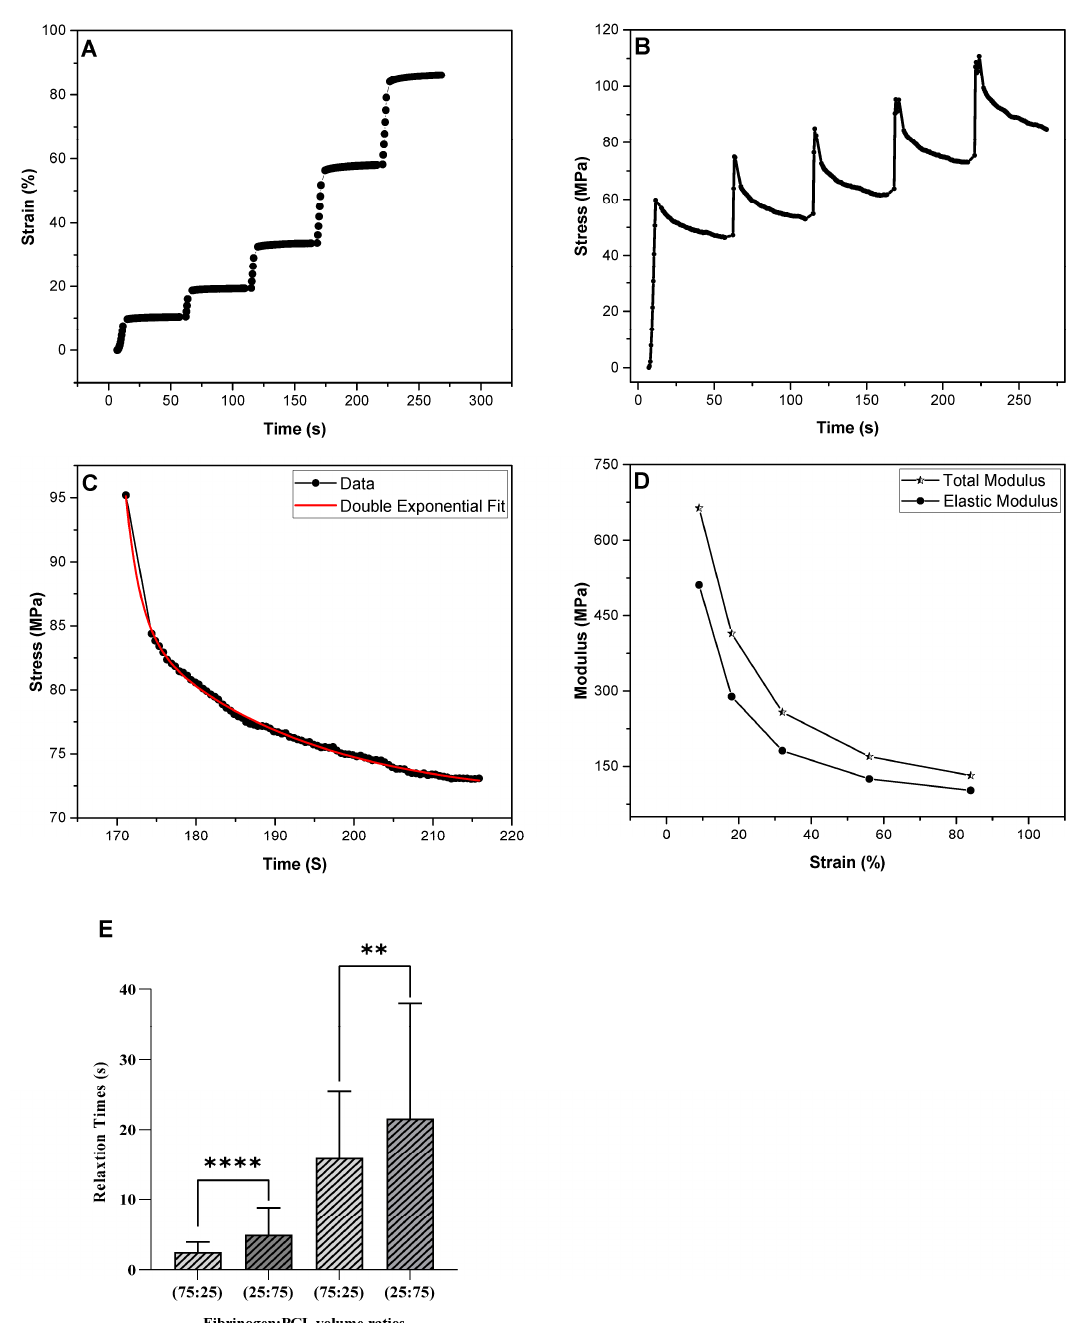
Figure 4. Incremental stress–strain curves. ( A ) Strain versus time curve for electrospun 75:25 fibrinogen:PCL fiber. The fiber was pulled to a small strain (~10%) and held constant for approximately 30–40 s; this process was repeated with a slightly larger strain at each time. ( B ) Stress versus time curve. At constant strain, the stress relaxes and decays exponentially with time. ( C ) Representative stress relaxation curves. A double exponential curve is fitted to the relaxation curve (R 2 = 0.99) to determine the relaxation times. The fast and slow relaxation times for this curve were 1.8 s and 21 s. ( D ) Moduli versus strain curve. The total modulus, Y tot , (stars) and relaxed, elastic modulus, Y 0 , (dots) decrease as the strain increases. ( E ) The graph shows statistical differences between the slow and fast relaxation times of the fibers with two different ratios. The fiber diameter was 99 nm. ** indicates a p -value < 0.01; **** indicates a p -value <